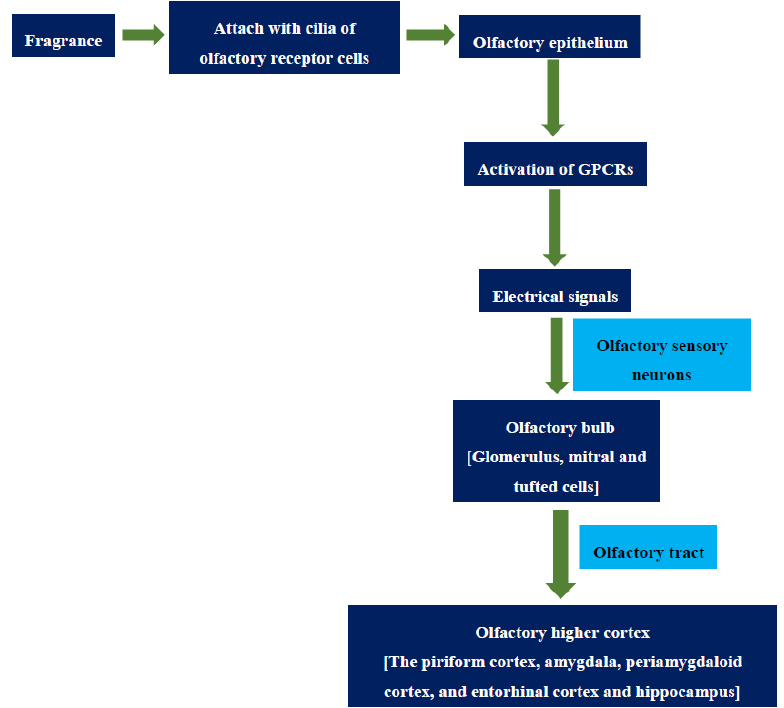
Figure 1. Schematic representation of the olfactory process. GPCR: guanine nucleotide binding protein coupled receptors